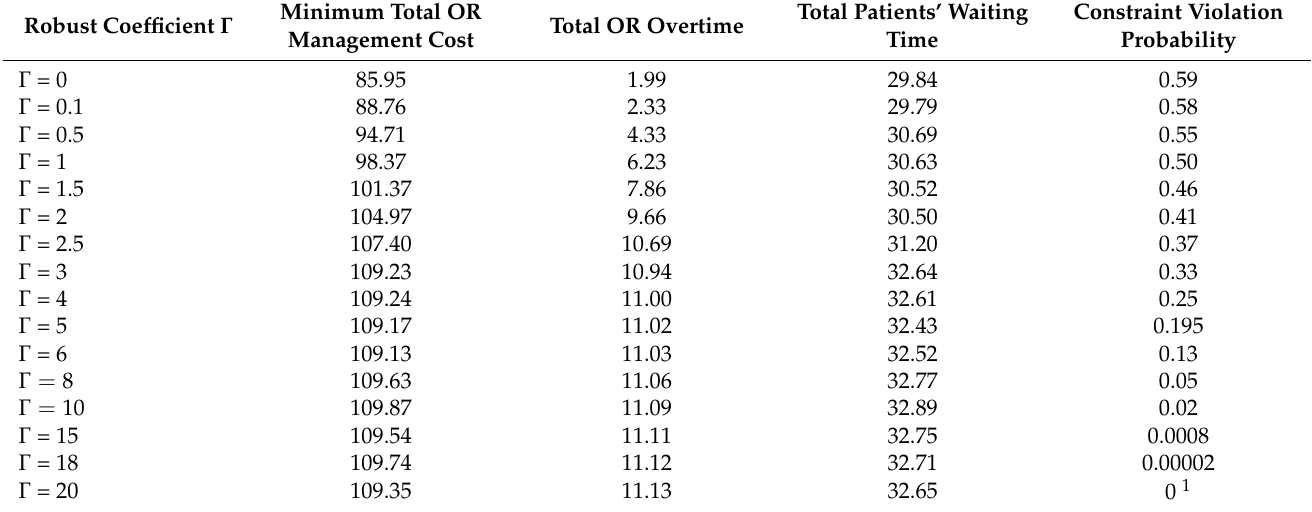
Table 2. Minimum total OR management cost, total OR overtime, total patient waiting time, and the constraint violation probability under different robustness coefficient Γ